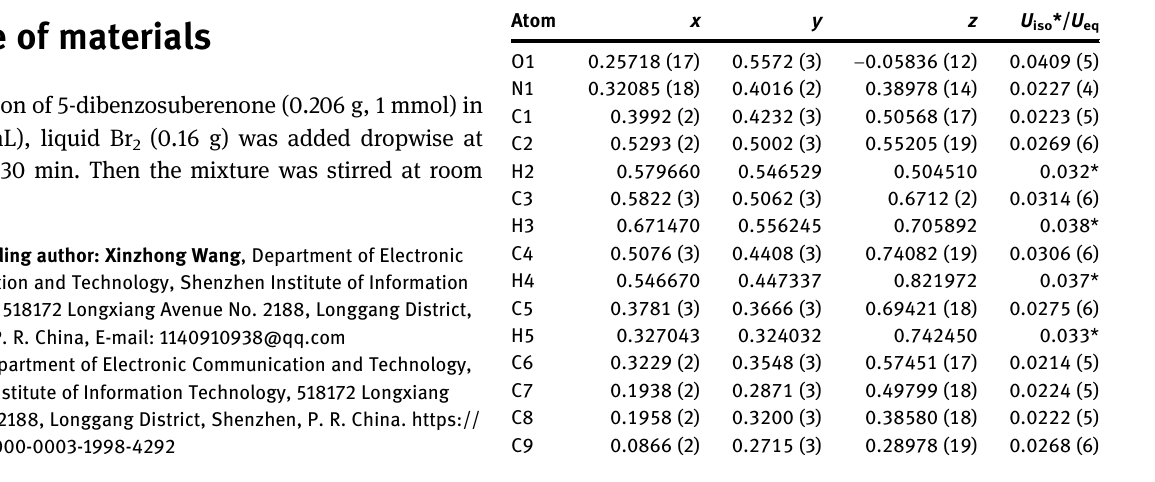
Table  : Fractional atomic coordinates and isotropic or equivalent isotropic displacement parameters (Å 